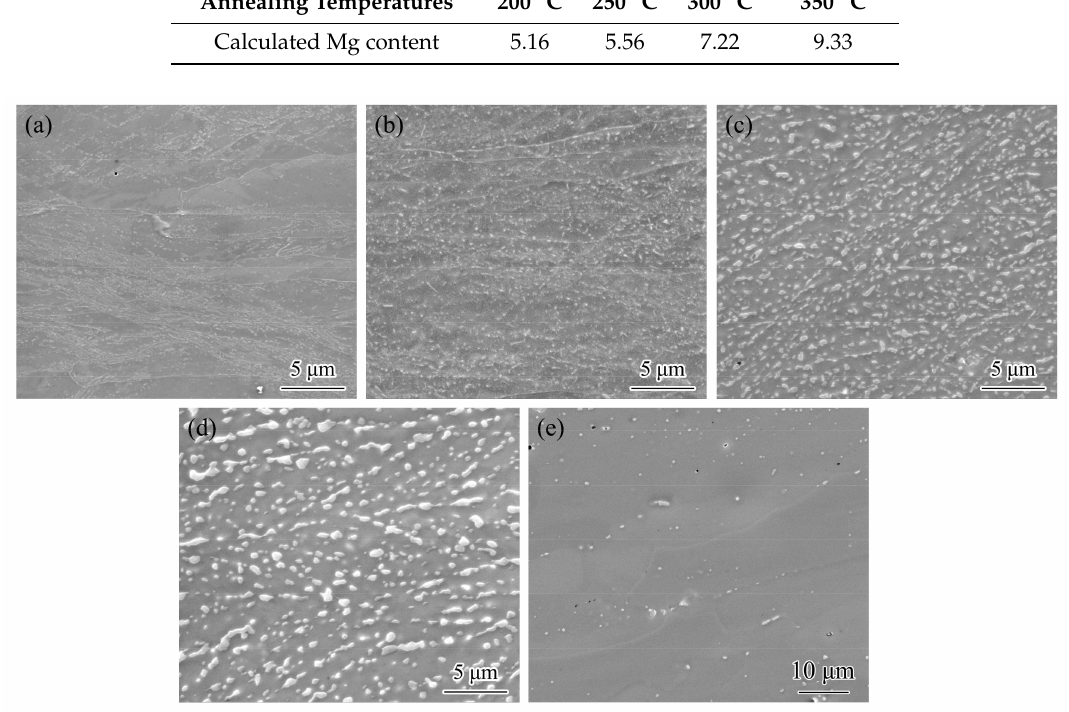
Figure 2. Secondary scanning electron microscopy microstructure of cold-rolled Al–10Mg